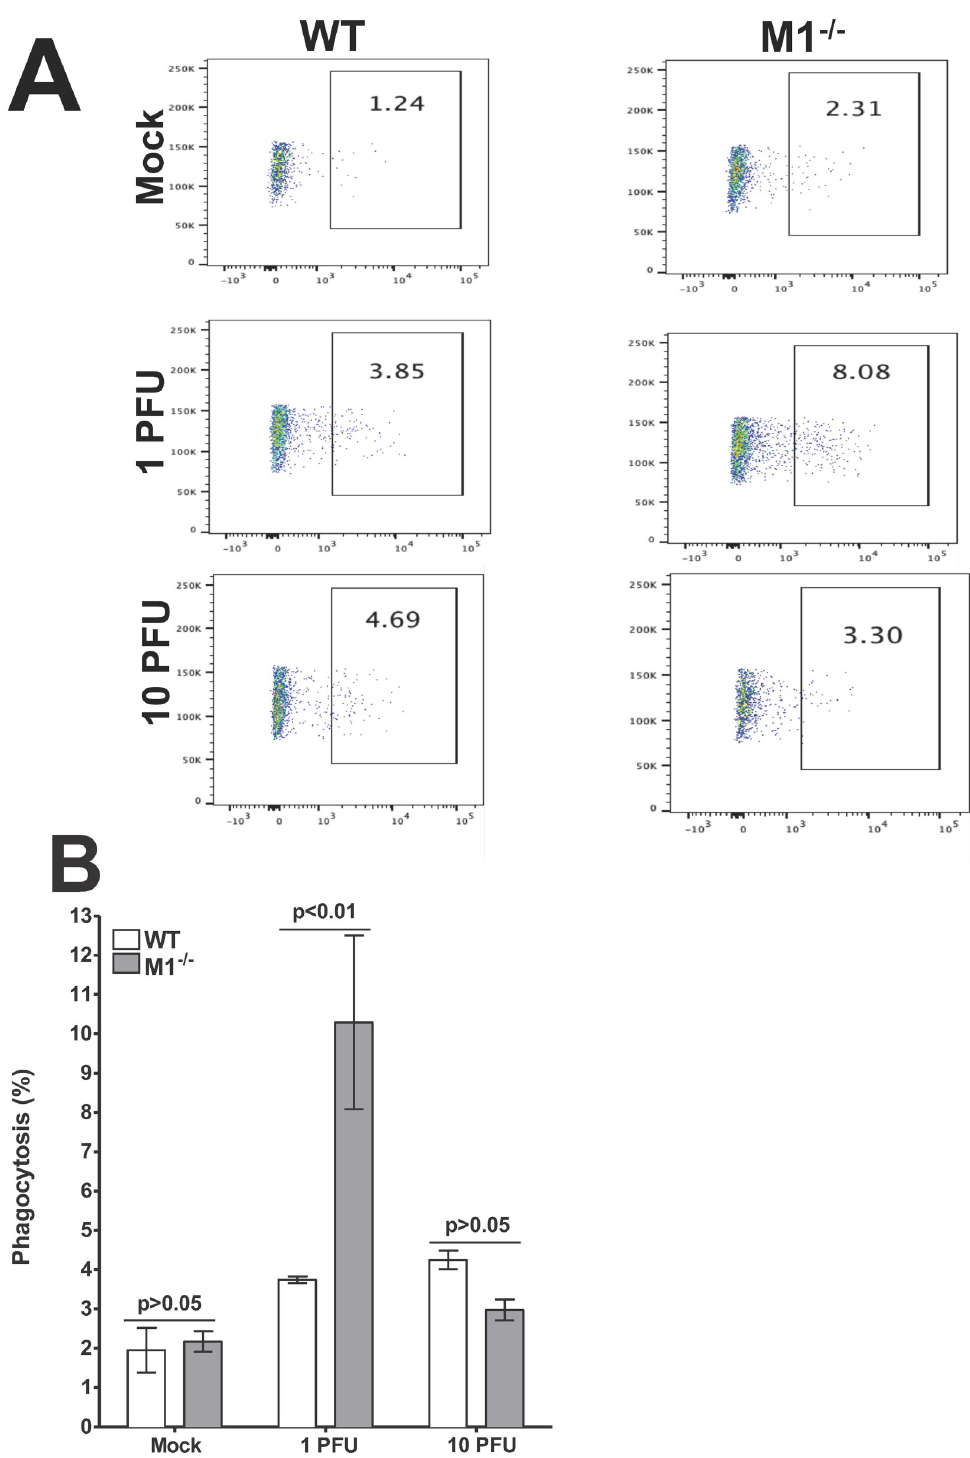
Fig 4. Phagocytosis assay on in vitro derived bone marrow-derived (BM) macrophages. Bone marrow cells from WT and M1 -/- mice were cultured and differentiated into macrophages with appropriate culture conditions as described in Materials and methods. After generating macrophages, adhered cells were infected with 1 or 10 pfu/cell of McKrae virus for 1 hr. Infected cells were harvested 24 hr PI and incubated with latex beads complexed with rabbit IgG-FITC. Cells were stained with F4/80 AF 564 antibody and analyzed by flow cytometry. Panels: A) Representative plots of WT and M1 -/- BM cells; and B) Percentage phagocytosis plots from three separate experiments.